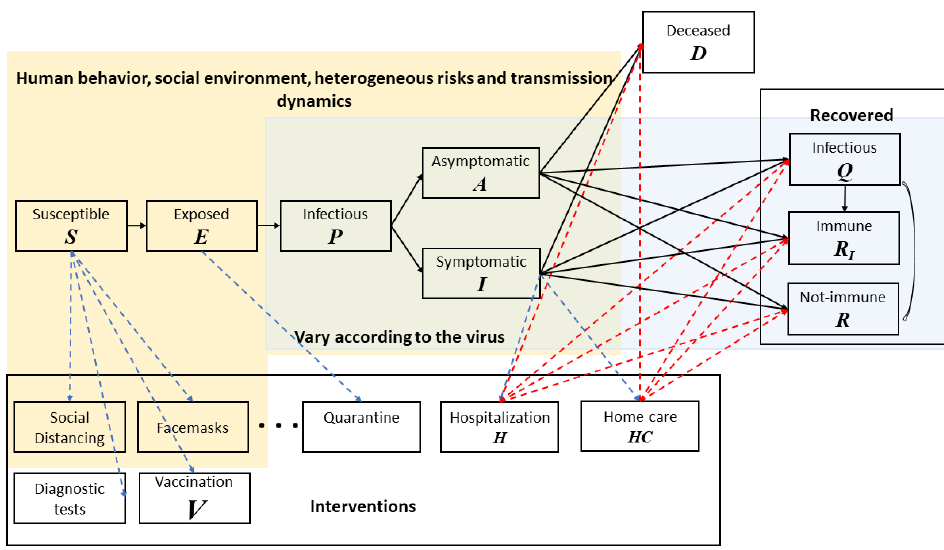
Figure 12. The biological-behavior-intervention informatics computational framework. The solid line arrows represent the natural disease progression. The blue dotted line arrows represent paths individuals take on an intervention; it can be via behavior or social environmental changes; or due to available resources (e.g., diagnostic tests, hospital beds). The red dotted line arrows reflect pathways of patient conditions upon receiving intervention. The figure includes some example interventions and pathways.